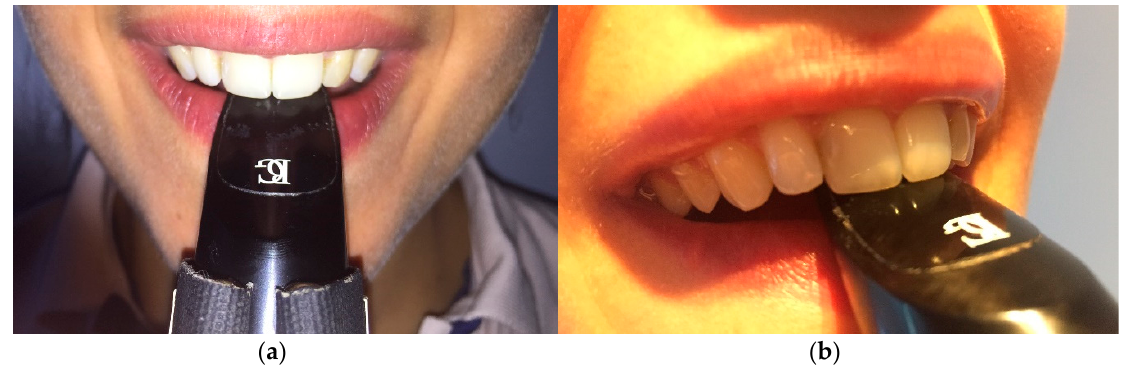
Figure 7. Analyses of the musician’s embouchure before incorporating the piezoresistive sensors in the mouthpiece. ( a ) The embouchure is slightly deviated to the left side where the tooth 21 contacts a large area of the mouthpiece; ( b ) The upper central incisors and the lower lip are responsible to stabilize the mouthpiece while performing the embouchure.